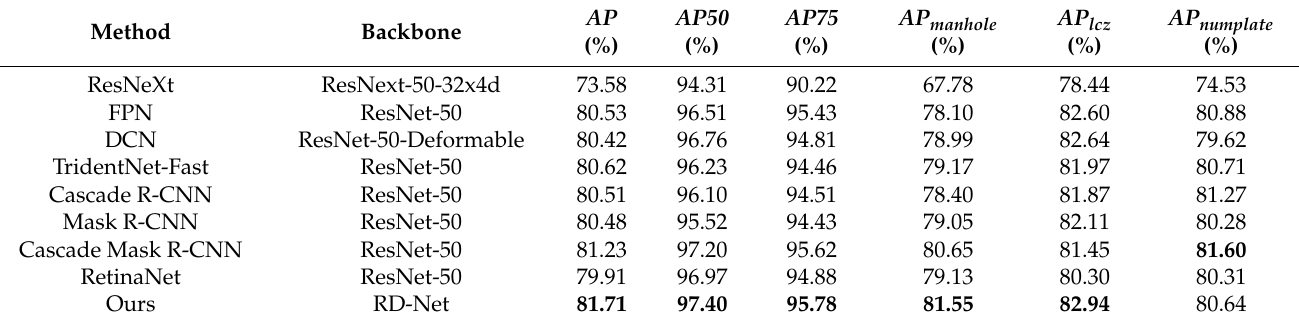
Table 7. Performance comparison between the proposed method and state-of-the-art methods on the UED dataset.